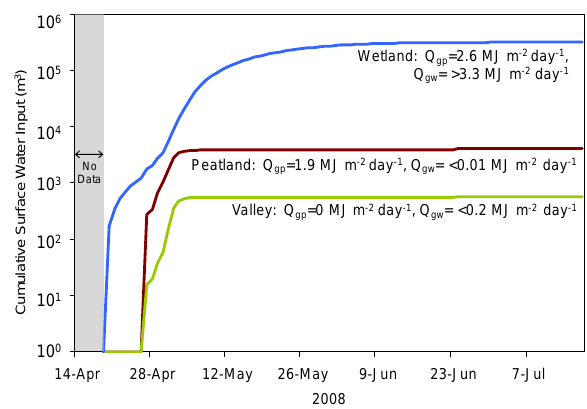
Fig. 5. Surface water input to the sites (snowmelt runoff at all sites and additional lake input at wetland site) and potential amount of energy from water available for ground thaw at each site. No Lake 690 data were available before 20 April 2008. Q gp is conductive heat energy from ponded water and Q gw is advec- tive heat energy from surface water flow. The wetland Q gw of 3.3MJm − 2 day − 1 is derived from dividing the overall site daily mean of 1.09 × 10 5 MJday − 1 evenly over the 3.3ha site. However, the actual fraction of area influenced by surface water was much smaller. For example, 35% of the 3.3ha site had flowing or stand- ing water on 6 June, resulting in ∼ 9.5MJm − 2 day − 1 of potential Q gw available for transfer into the frozen ground. See Eq. (13) for details on energy